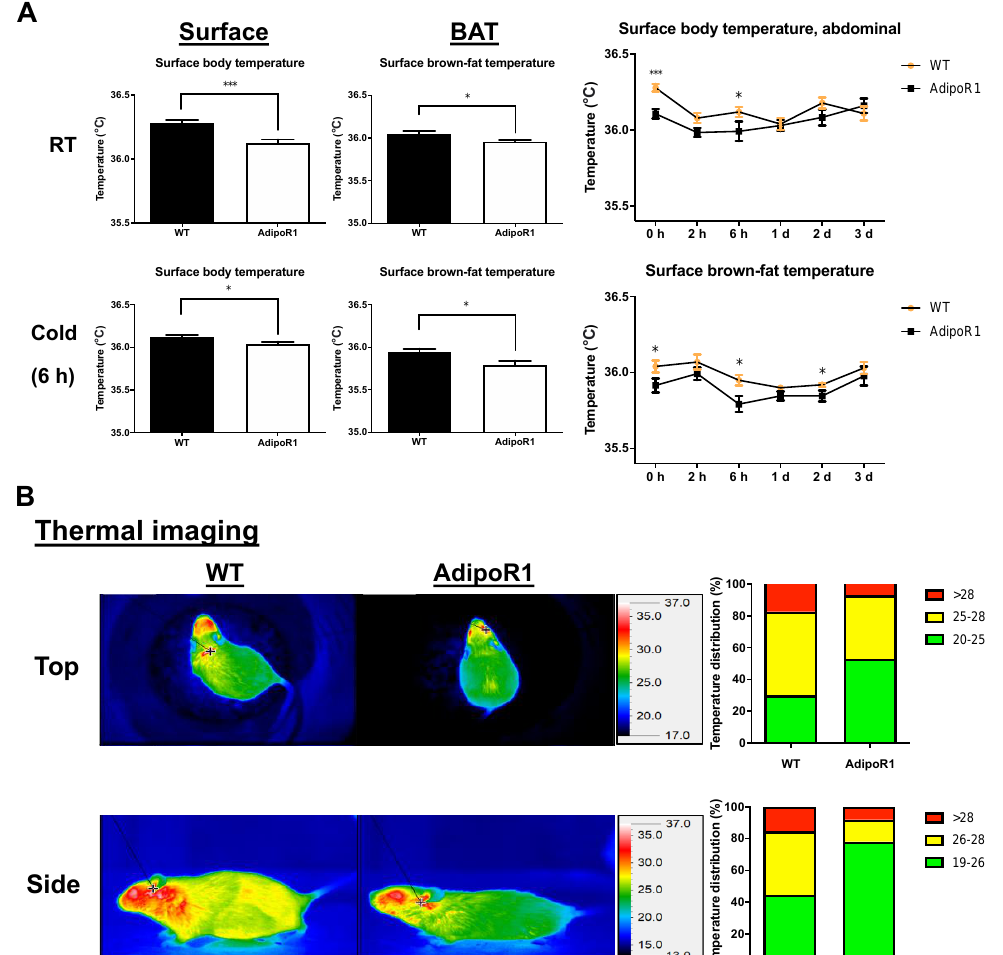
Figure 4. Reduced surface BAT depot temperature and surface body temperature of AdipoR1 mice. WT and transgenic AdipoR1 mice were evaluated for surface body temperature, ( A ) by infrared thermometer both at room temperature (RT) and after cold induction, and ( B ) by infrared camera after cold induction. Timeline and procedures were described in Figure 1. Measurements of surface body temperature (abdomen region) and surface depot temperature of BAT in ( A ) and infrared images from the thermographic surface temperature analysis in ( B ) in WT and AdipoR1 mice were both quantified and expressed as means ± SEM ( n ≥ 8 for each group). * p ≤ 0.05; *** p ≤